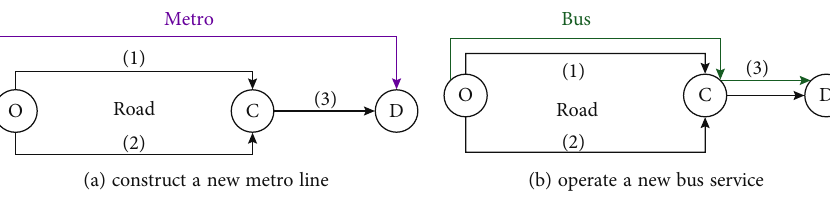
Figure 6: Schemes of adding new mode to the road